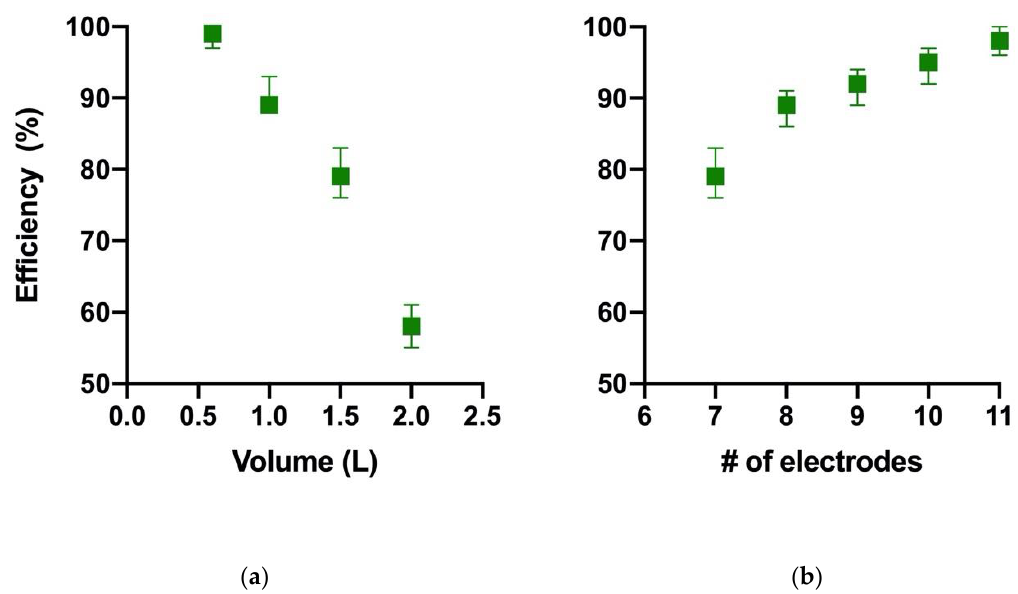
Figure 2. Efficiency of concentration using different volumes of algae culture ( a ) and different Figure 2. E ffi ciency of concentration using di ff erent volumes of algae culture ( a ) and di ff erent numbers numbers of electrodes ( b ) at 150 rpm and 6 electrodes. of electrodes ( b ) at 150 rpm and 6